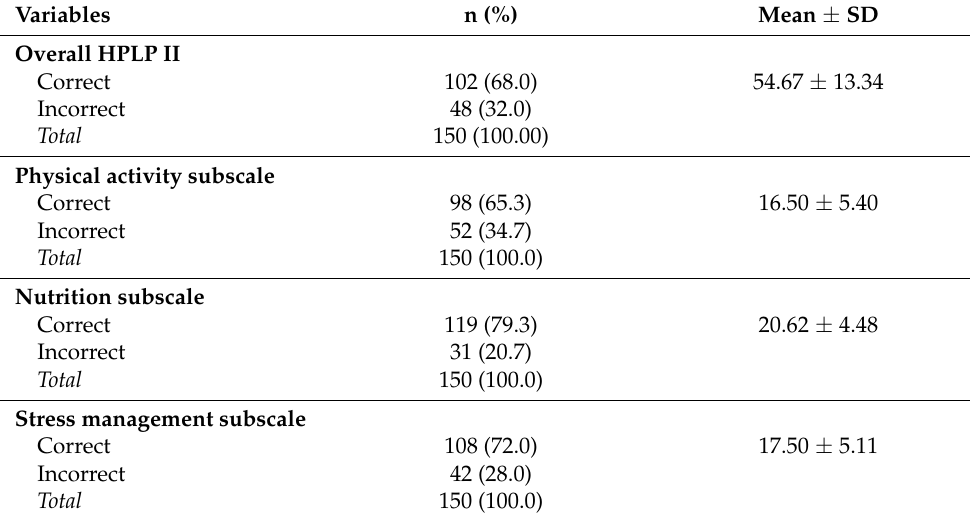
Table 2. Evaluation of health promoting lifestyle of participants.